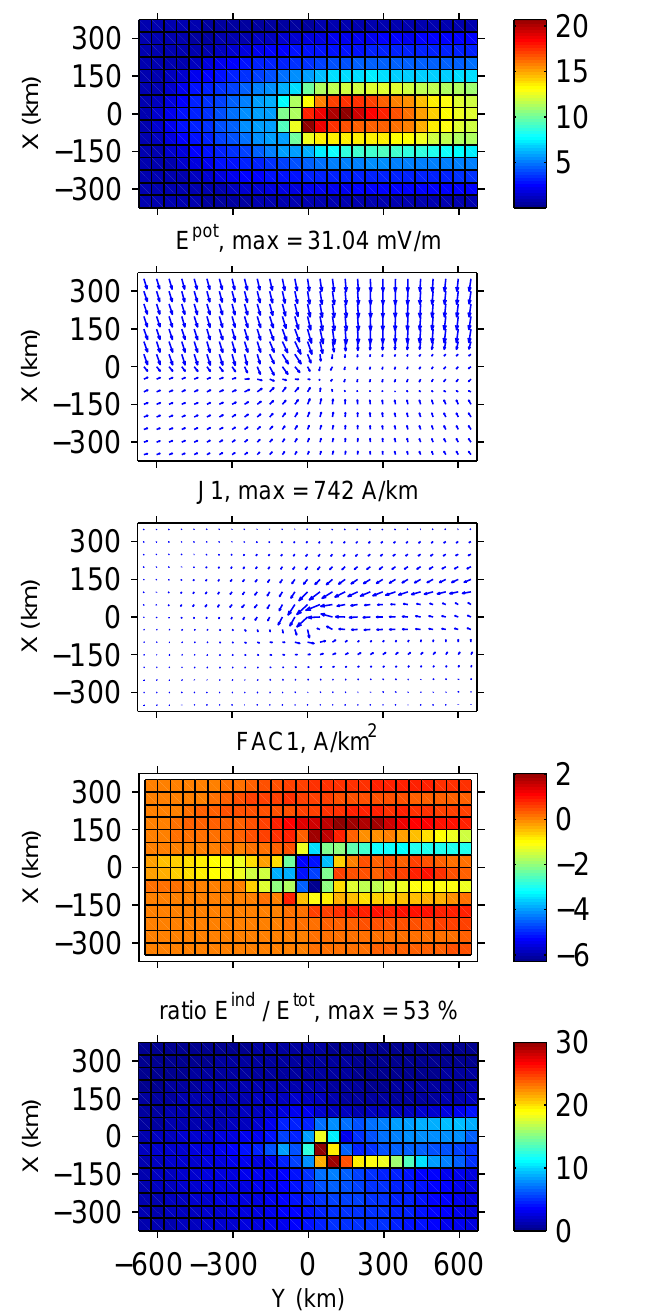
Fig. 8. Same as Fig. 5, but for the WTS model.